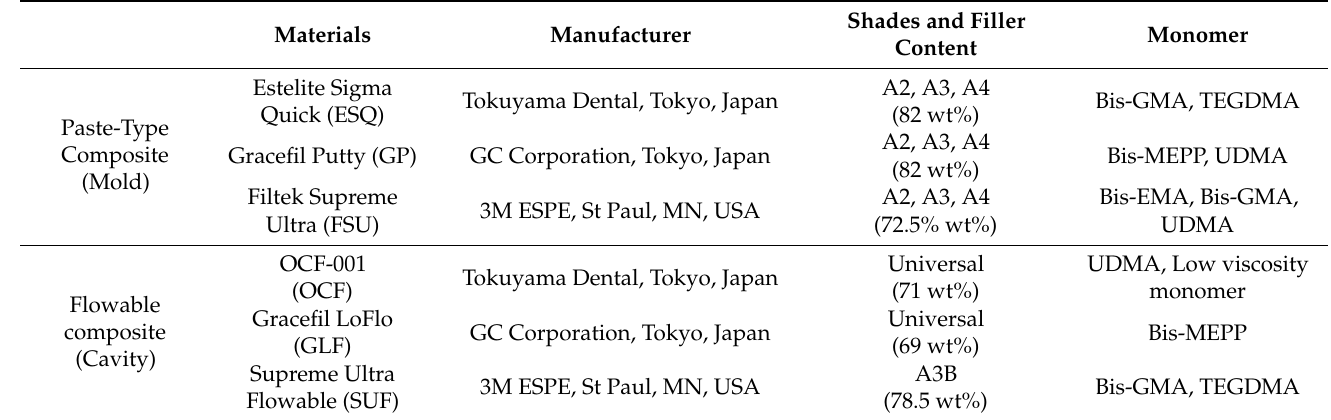
Table 1. Manufacturers, shades, filler contents, and monomers of paste-type composite for the molds and flowable composites for